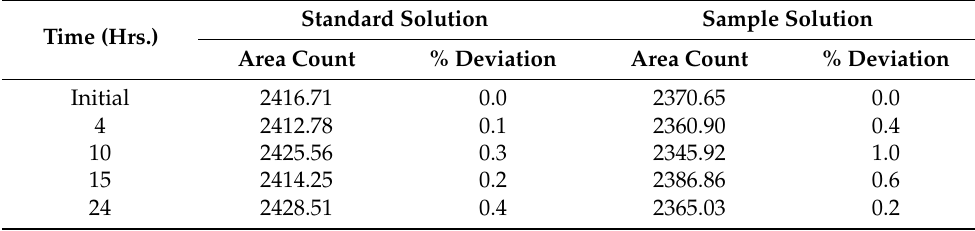
Table 6. Solution stability